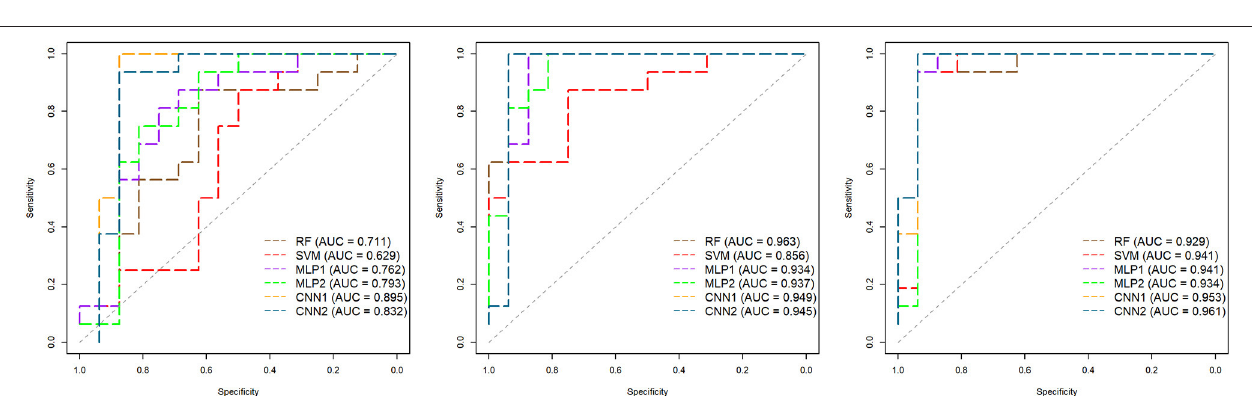
FIGURE 10 | Accuracy, specificity, and sensitivity values for the classification of Brazilian horses gait types (MB and MP) in an independent dataset ( N machine learning algorithms (RF, Random Forest; SVM, Support Vector Machine; MLP, Multilayer Perceptron Neural Networks; CNN, Convolutional Neural Networks) trained with different feature datasets extracted from audio data ( A —Mel-frequency Cepstral Coefficients, B —Onset Strength and C —Tempogram). MLP1, MLP2, CNN1, and CNN2 refer to the different neural network architectures used for each audio-feature dataset (as fully presented in Supplementary Table 1 ).